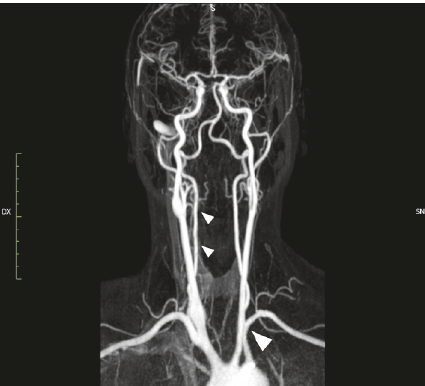
Figure 1: Magnetic Resonance Angiography (MRA) showing nar- rowing of the common carotid arteries bilaterally and the left subclavian artery (large arrowhead). Vertebral and intracranial carotid arteries were normal